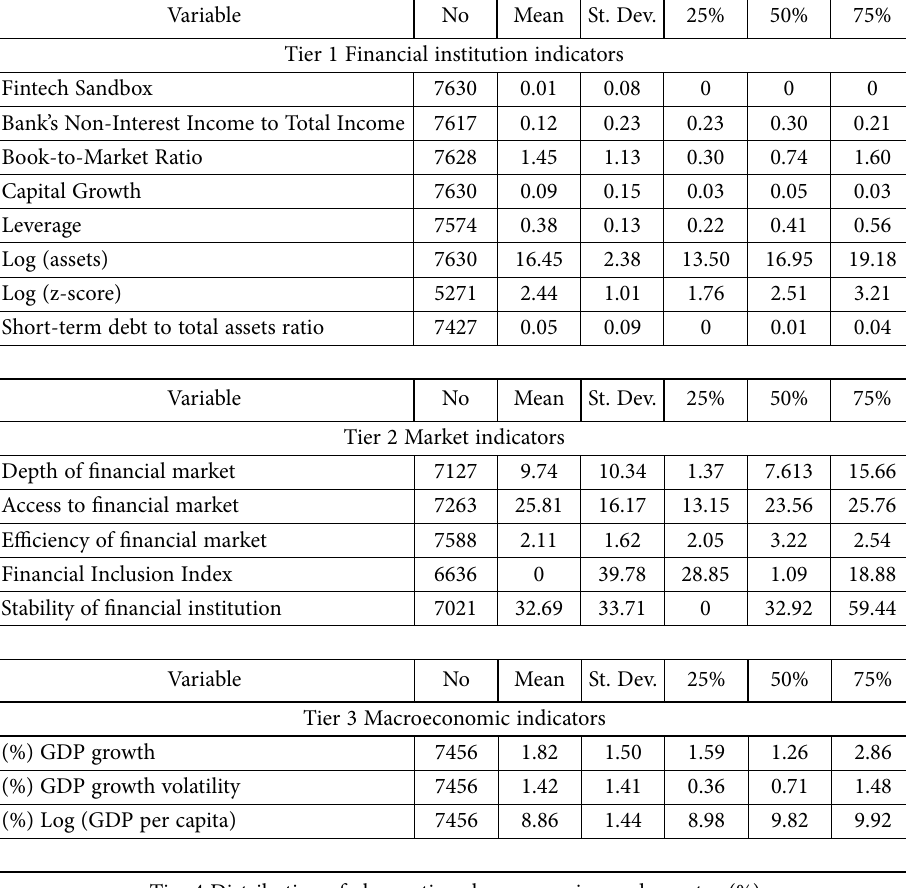
Table 1. Descriptive statistics of the financial institution, market and macro-economic country-level indicators Variable No Mean St. Dev.